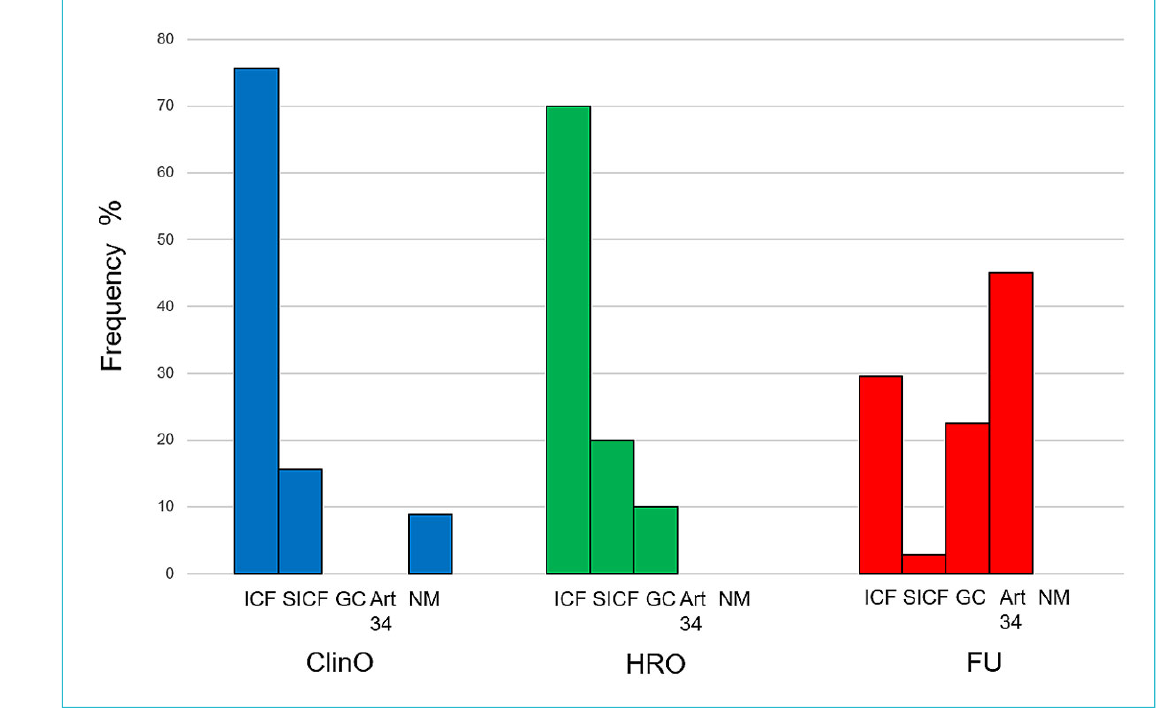
Figure 4: Information procedures of participants in genetic research.ICF = informed consent form; SICF = specific informed consent form; GC = general consent; Art 34 = no consent according to HRA article 34; NM = no mention of genetic testing in consent form; ClinO = clinical trials; HRO = research projects with persons; FU = further-use research projects using health-related person data or biological material. Multiple mentions are